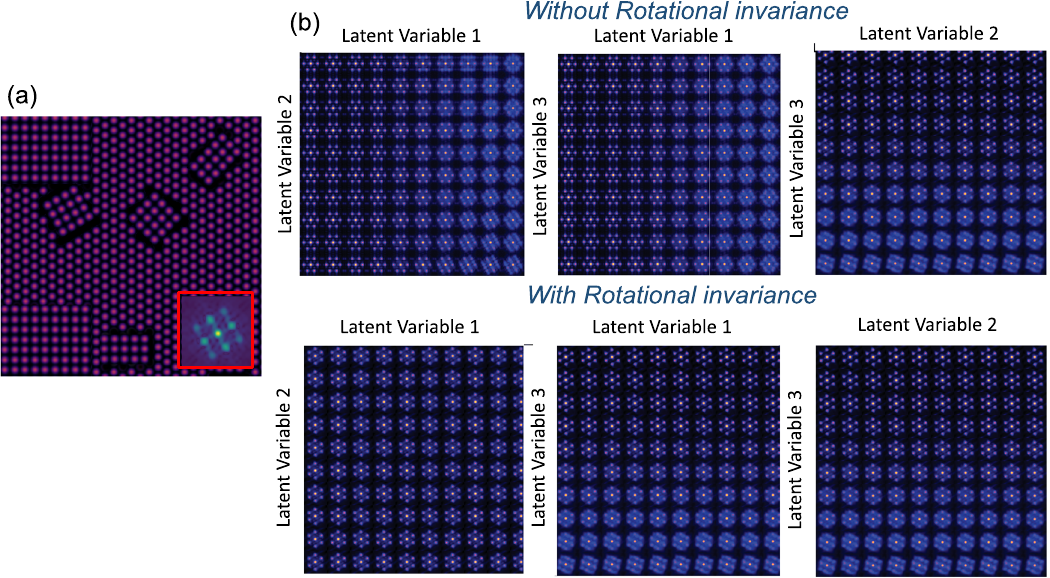
Fig. 3 Utility of adding rotational invariances when forming reduced representations. a A simulated test image (size 500 × 500 px) containing different lattice structures with arbitrary rotations. We aim to disentangle rotations of a structure from the actual structures themselves. For this purpose, we begin by computing a sliding window 2D Fourier transform 52 over the image, collecting hundreds of 2D local Fourier transformed images. We then aim to encode this dataset using a variational autoencoder. Shown in ( b ), ( c ) are the latent space visualizations for the encoder ( b ) without rotational invariance, and ( c ) with rotational invariance speci fi cally built-in to the loss function. It is easily observed that without rotational invariance, the latent space is forced to take into account rotations, decreasing the compactness of the representation. The latent space in ( c ), however, is much simpler